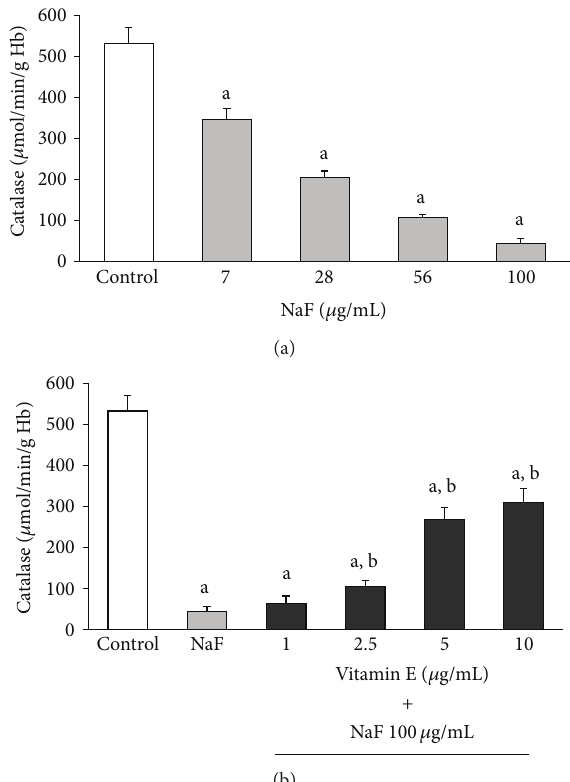
Figure 2: SOD activity in erythrocytes incubated in vitro for 3 hours with increasing concentrations of NaF (a) or incubated with 100 𝜇 g/mL NaF or 100 𝜇 g/mL NaF with Vit-E in increasing concentrations (b). The results are expressed as the mean ± standard deviation of five independent experiments, taking two samples per experiment and performing the determinations in triplicate. a 𝑃 < 0.05 compared with the control group; b 𝑃 < 0.05 compared with the group incubated with only 100 𝜇 g/mL NaF.